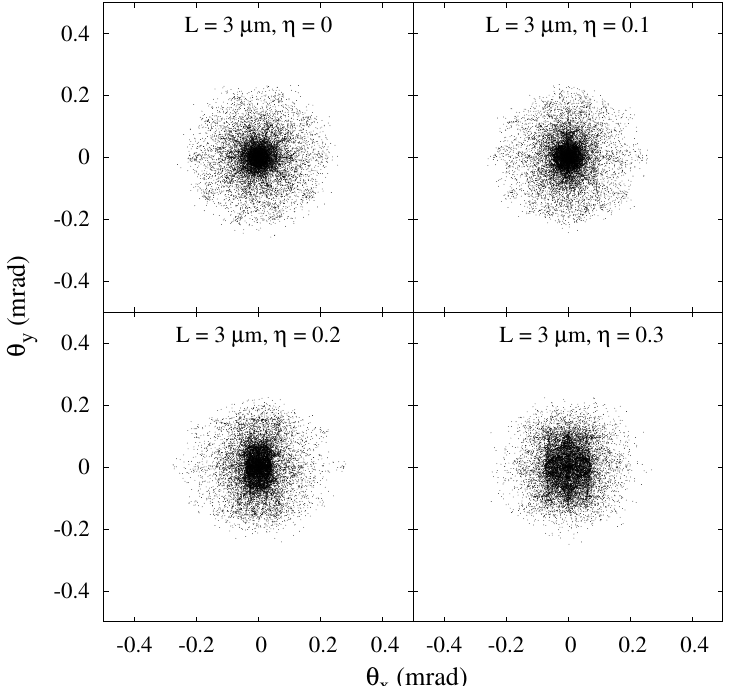
Figure 6. The angular distributions of protons channeled in the radially deformed DWNTs(10, 0)@(5, 0) under different radial strains: (left top) η = 0; (right top) η = 0.1; (left down) η = 0.2; (right down) η = 0.3, respectively. The proton energy is E = 1 GeV and nanotube length is L = 3 µ